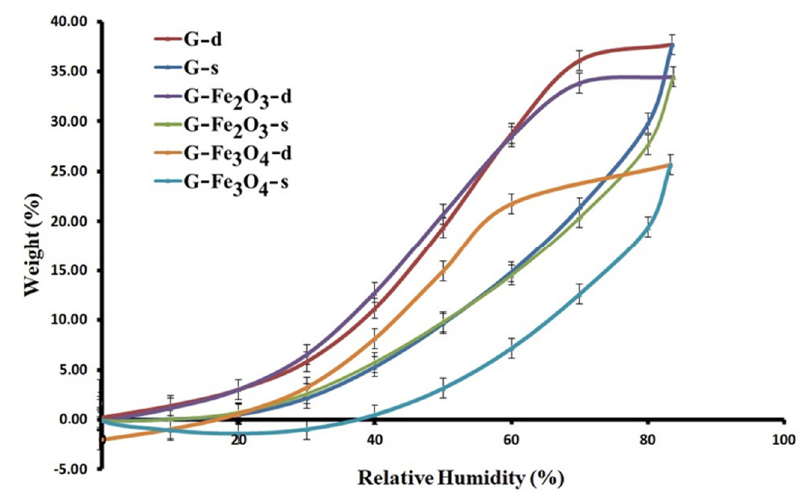
Figure 6. Sorption/desorption curves for the investigated gelatin-based composites.